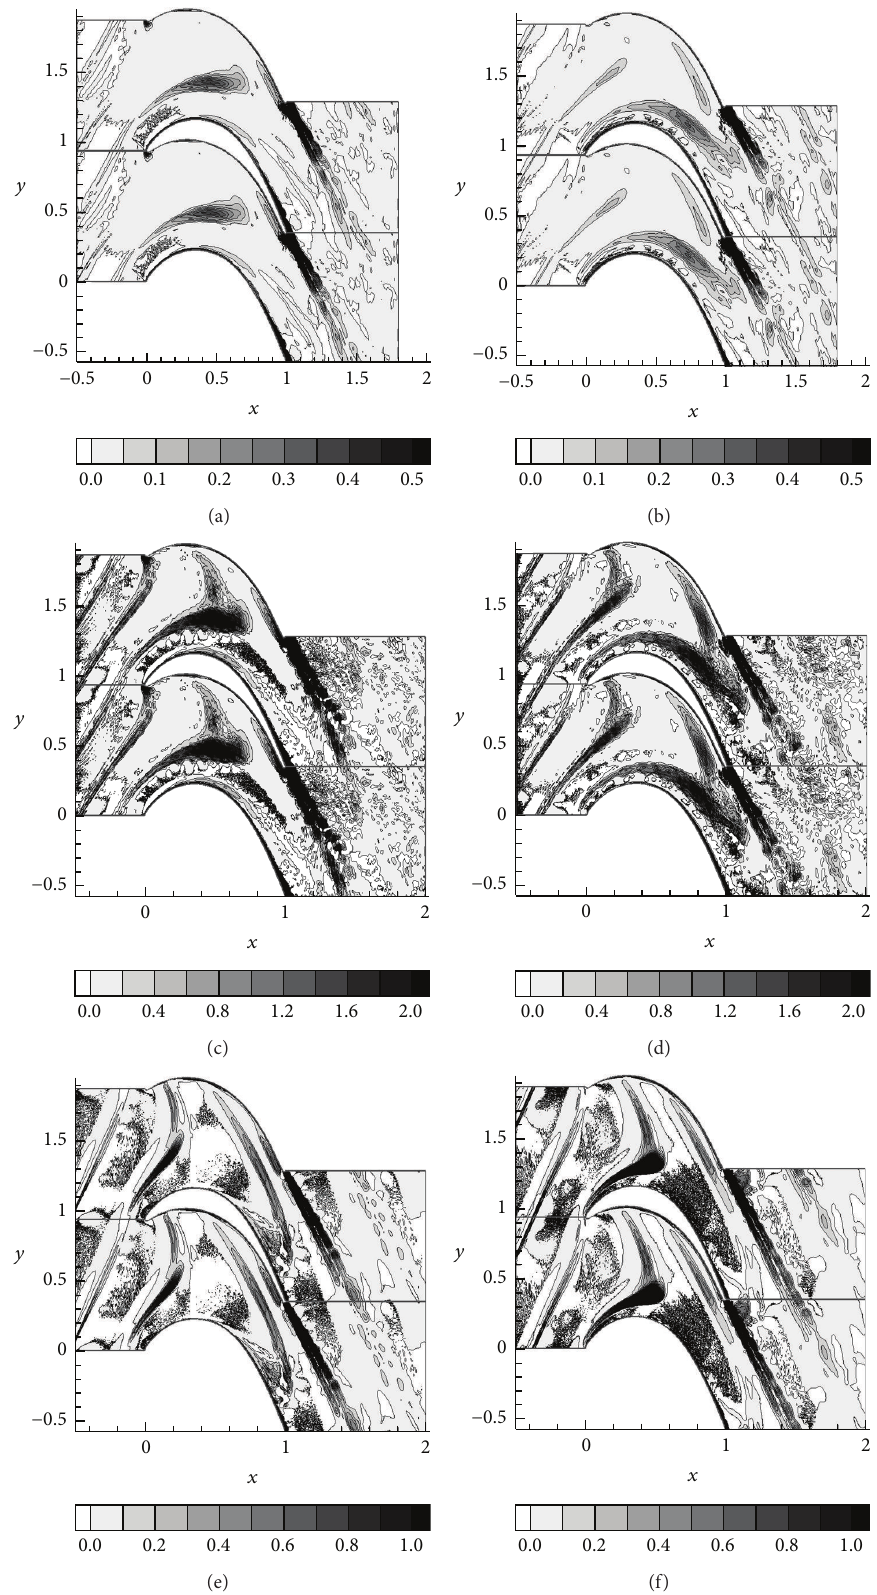
Figure 3: Phase-averaged production of turbulent kinetic energy: (a) LES: Re = 5.18 × 10 4 , Φ = 0.508 , (b) LES: Re = 5.18 × 10 4 , Φ = 0.008 , (c) DNS: Re = 5.18 × 10 4 , Φ = 0.508 , (d) DNS: Re = 5.18 × 10 4 , Φ = 0.008 , (e) LES: Re = 1.48 × 10 5 , Φ = 0.375 , and (f) LES: Re = 1.48 × 10 5 , Φ = 1.0